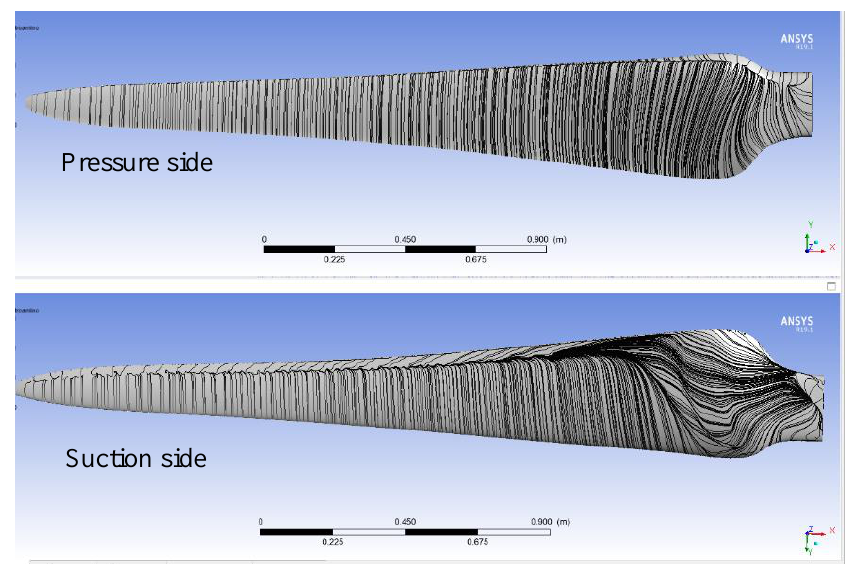
Figure 5. Limiting streamlines of the blade surface at the design condition.